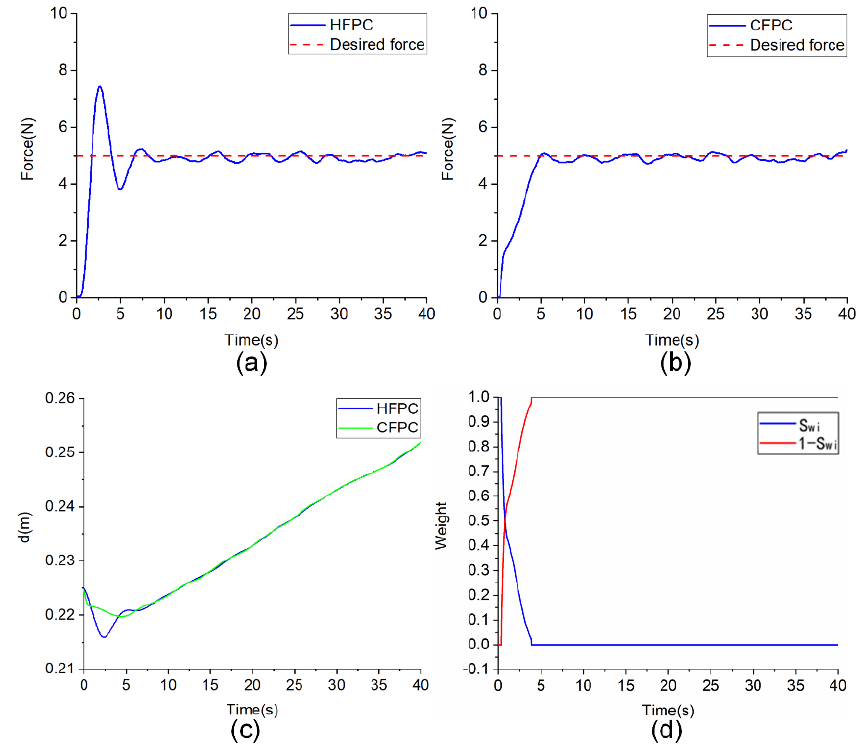
Figure 10. Constant force-tracking experiment on a sloped surface. Force tracking using ( a ) the HFPC and ( b ) proposed CFPC methods. ( c ) Position tracking. ( d ) Weighted parameter wi s .